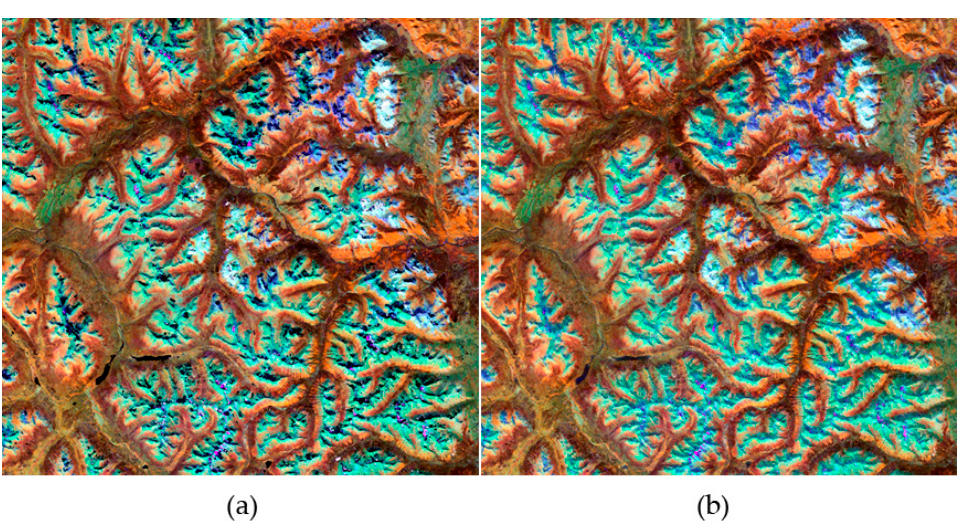
Figure 4. Results of shadow correction in mountain regions, before correction ( a ) and after ( b ).